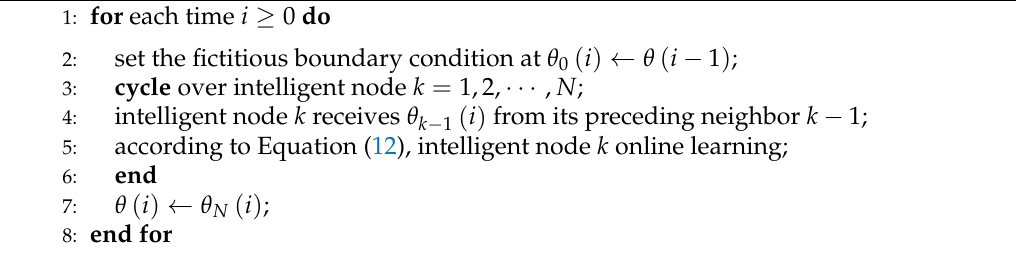
Algorithm 1: Increment strategy for distributed